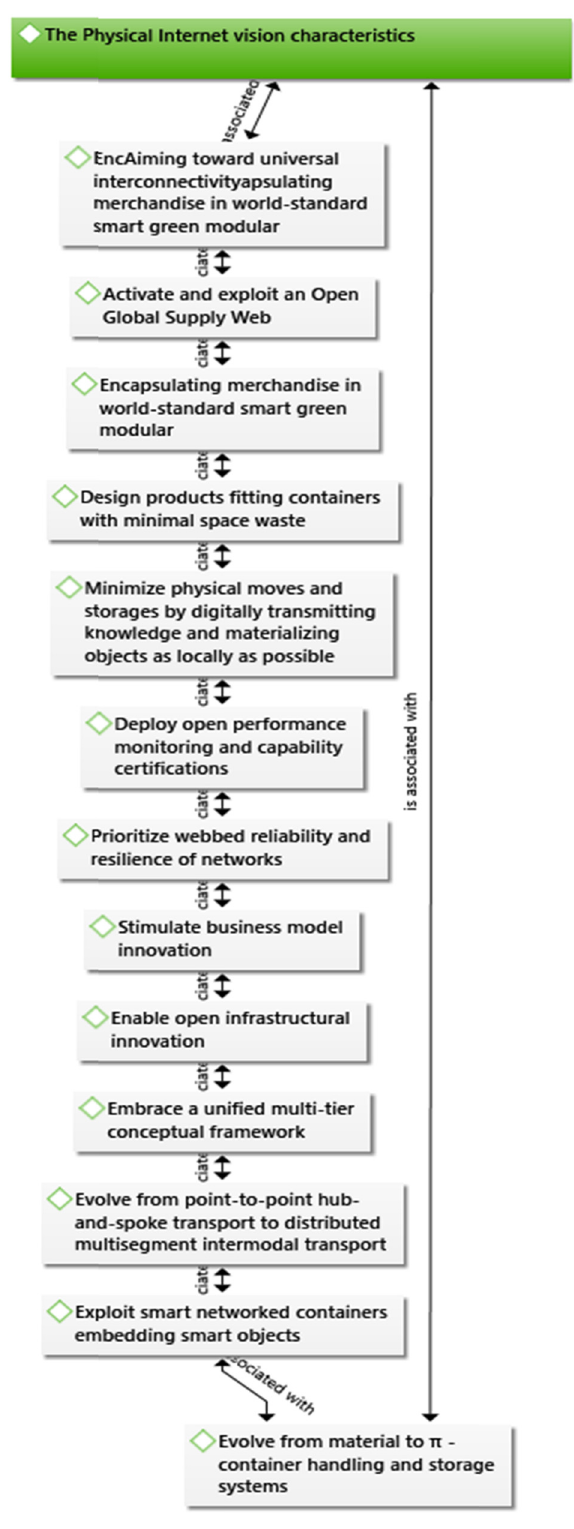
Figure 2: PI foundation framework. Source: Montreuil [ 9 ] . Figure 3: The 13 PI vision [ 9 ]